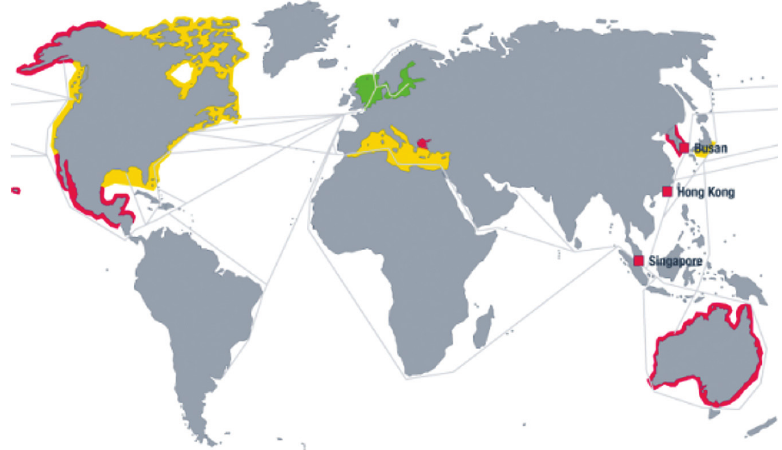
Fig. 1. ECAs zones: ■ existing ECA; ■ planned ECA; ■ discussed ECA; — most used trading routes (MAN Diesel & Turbo 2011) Table 2. Number of vessels registered in the Lithuanian